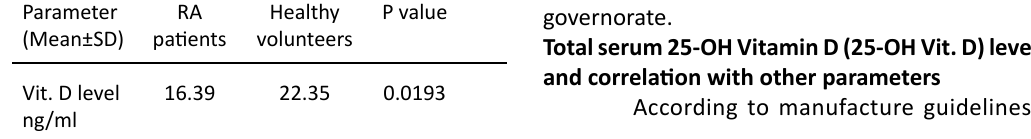
Table 2. Baseline characteristics of RA patients 25-OH Vit. D deficient and RA patients 25-OH Vit. D sufficient Parameter RA patients with